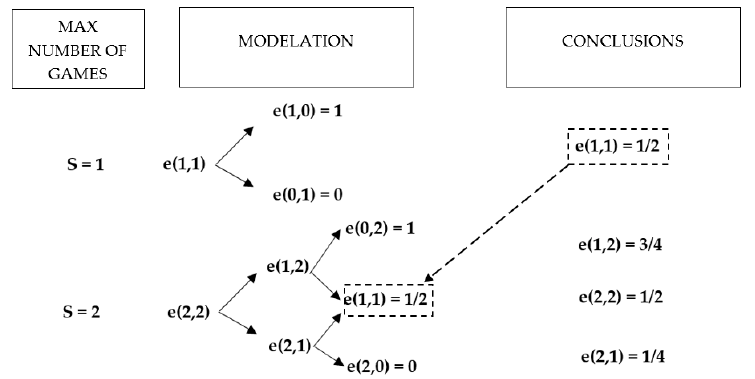
Figure 5. Pascal recursive reasoning. From the study of s = 1, a value of s = 2 is obtained. In the same way, from the study of s = 2, values of s = 3 can be obtained.